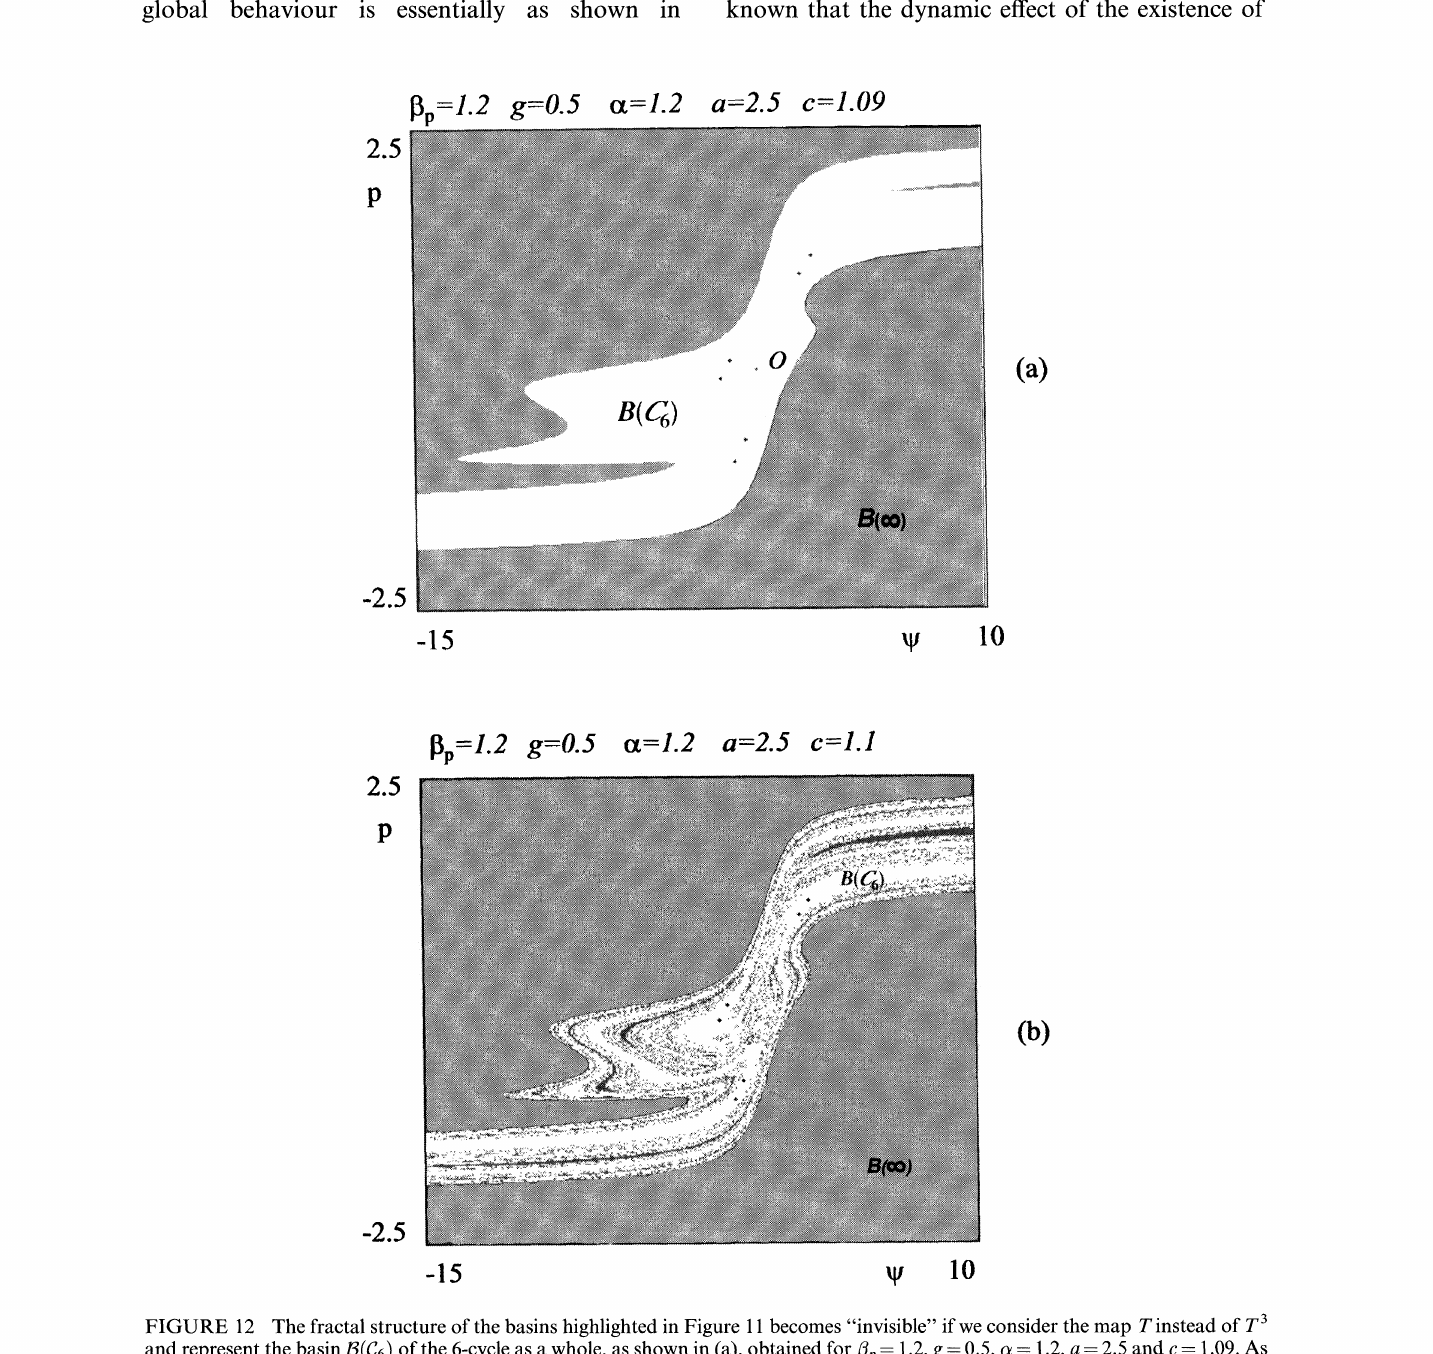
FIGURE 12 The fractal structure of the basins highlighted in Figure 11 becomes "invisible" if we consider the map T instead of T and represent the basin/3(C6) of the 6-cycle as a whole, as shown in (a), obtained for/3p 1.2, g 0.5, c 1.2, a 2.5 and c 1.09. As c increases another homoclinic bifurcation, similar to the one observed in Figure 11, but now involving a saddle cycle belonging to 0/3(), causes the spread of portions of/3() inside the old white area, as shown in (b), obtained for e--- 1.1. (c) represents the structure of the basins for the same parameters values, but considering the map T